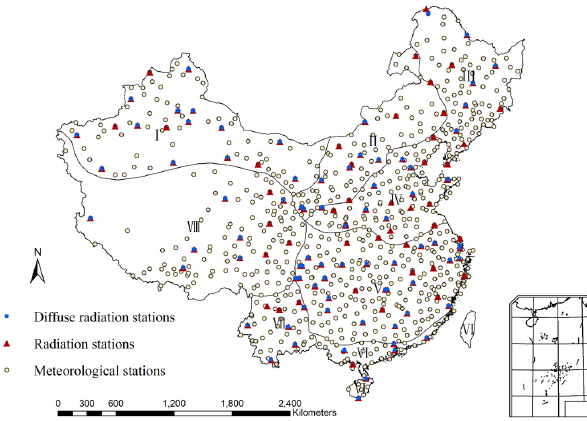
Fig. 1. Distribution of meteorological and radiation stations in China (I: northwest China; II: Inner Mongolia; III: northeast China; IV: north China; V: central China; VI: south China; VII: southwest China; VIII: Qinghai-Tibet